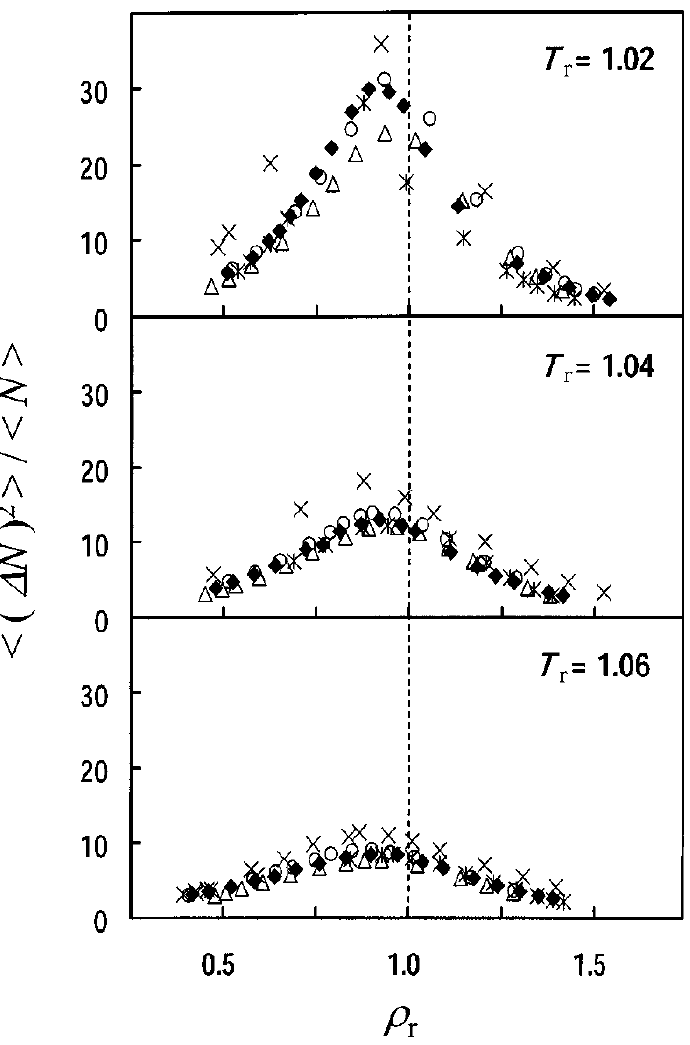
Figure 4. A comparison of the density fluctuations among H 2 O (cross), CO 2 (triangle), CF 3 H (circle), C 2 H 4 (asterisk), and benzene (closed diamond) at T r = 1.02, 1.04, and 1.06. This figure is reprinted from JCP , 2003 , 119 , 1502.